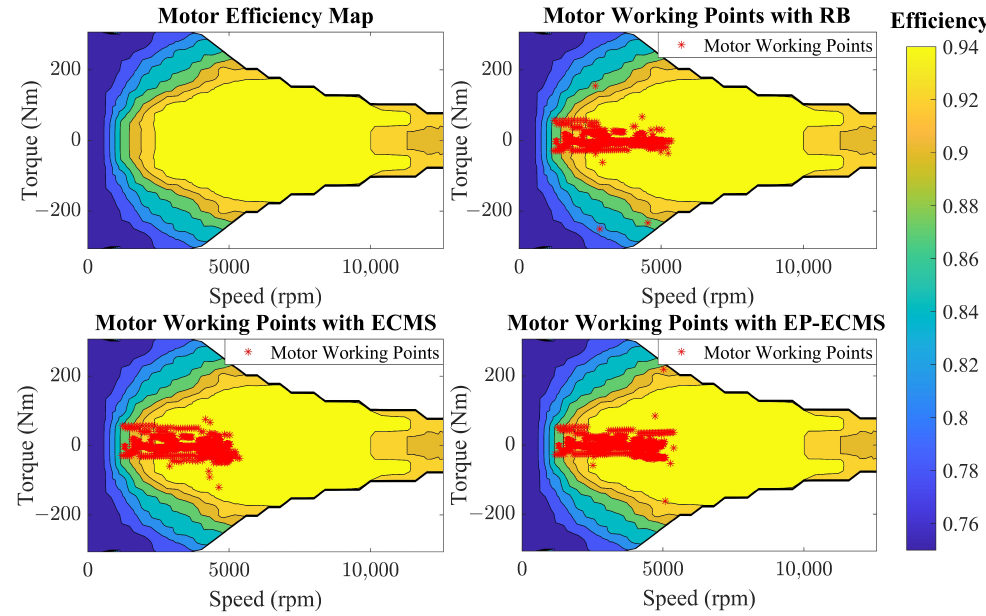
Figure 14. The motor working point in the efficiency